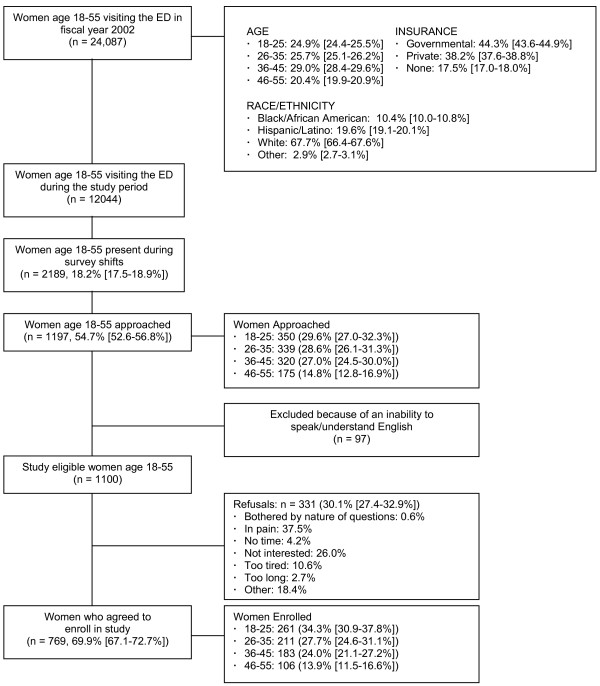
Enrollment diagram.